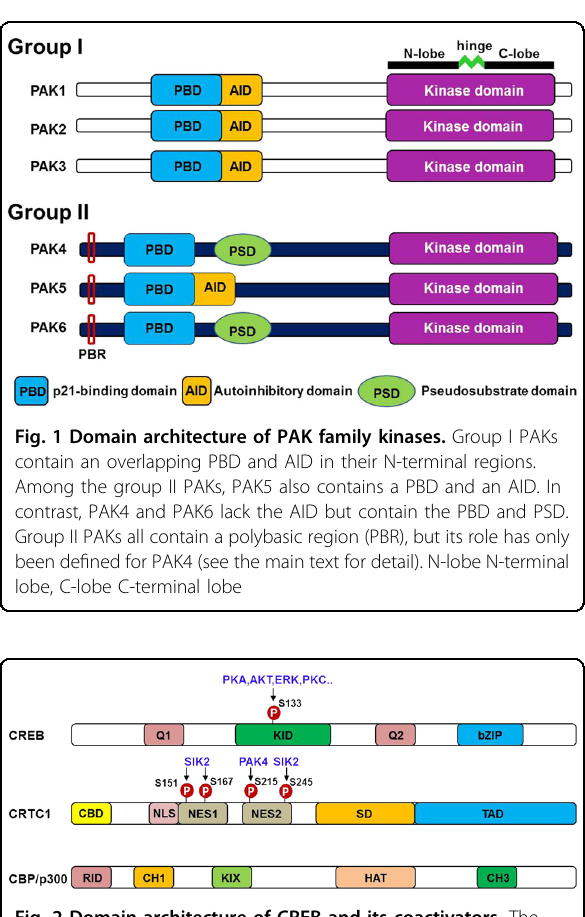
Fig. 2 Domain architecture of CREB and its coactivators. The functional domains and major phosphorylation sites of CREB and its coactivators are shown. Kinases responsible for phosphorylating each amino acid residue are also depicted. KID kinase-inducible domain, CBD CREB-binding domain, NLS nuclear localization signal, NES nuclear export signal, SD splicing domain, TAD transactivation domain, RID nuclear receptor interaction domain, CH Cys- and His-rich region, KIX KID-interacting domain, HAT histone